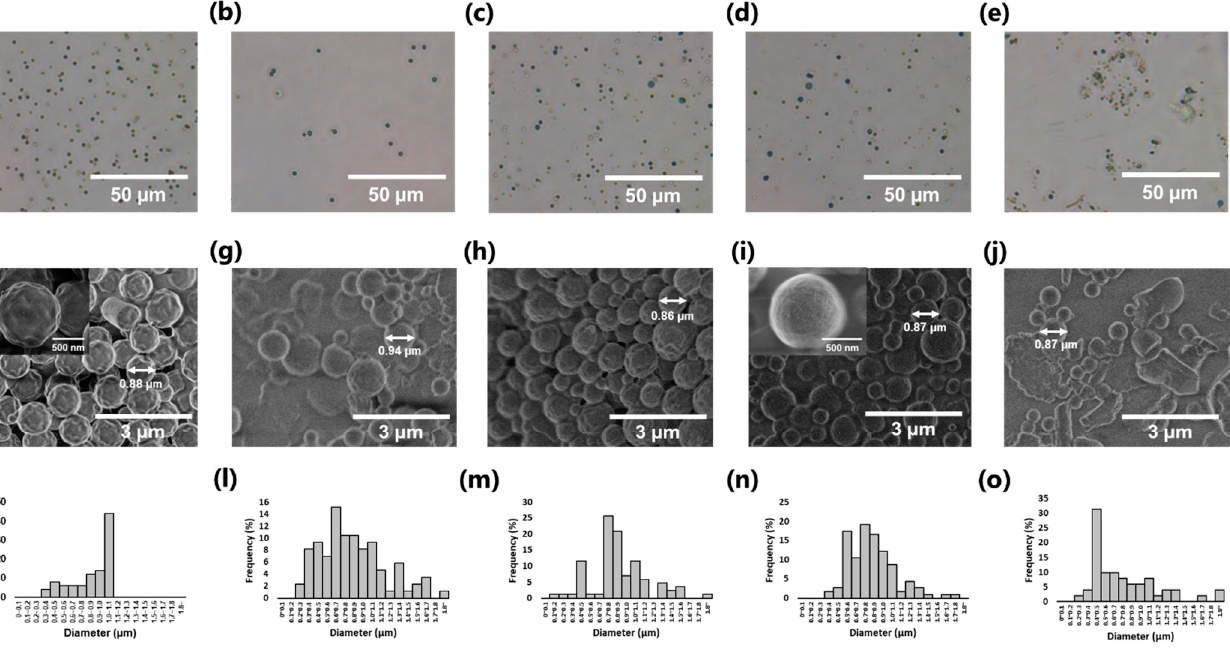
Figure 4. ( a – e ) Optical images, ( f – j ) SEM images, and ( k – o ) particle size distribution histograms of MPs synthesized with different concentrations of TOCNF: ( a , f , k ) 0% ( w/v ), ( b , g , l ) 0.3% ( w/v ), ( c , h , m ) 0.5% ( w/v ), ( d , i , n ) 0.8% ( w/v ), and ( e , j , o ) 1.0% ( w/v ). Insets of ( f , i ) show magnified picture of each one microparticle.